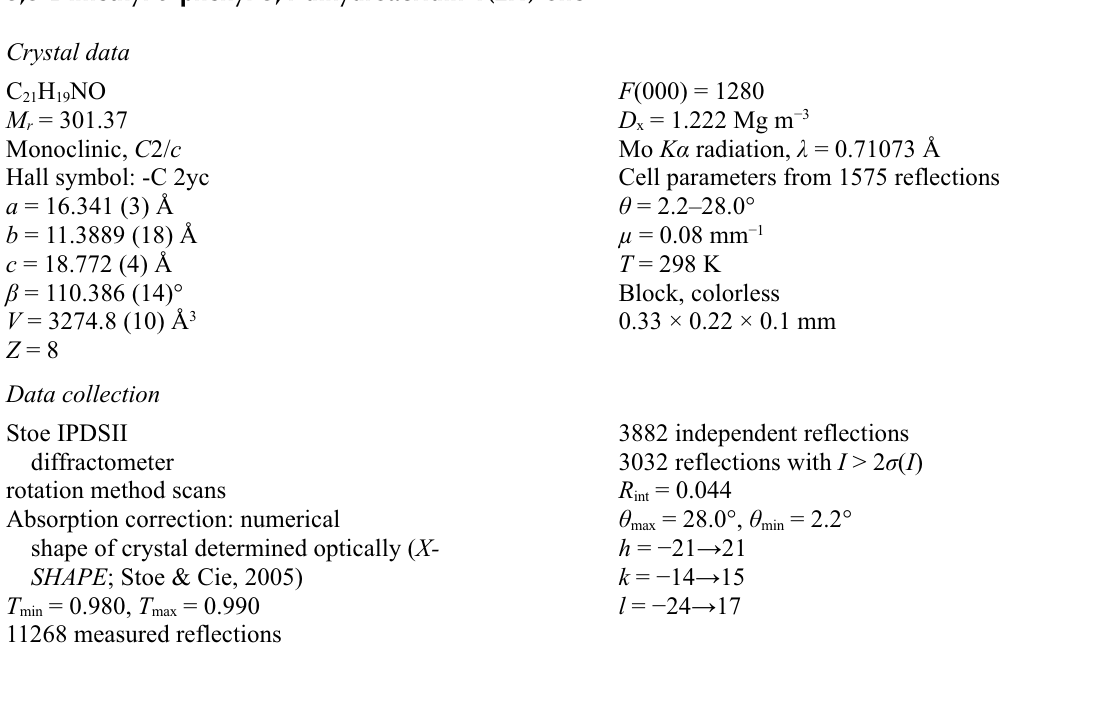
The molecular structure of the title molecule, with the atom-numbering scheme. Displacement ellipsoids are drawn at the 30% probability